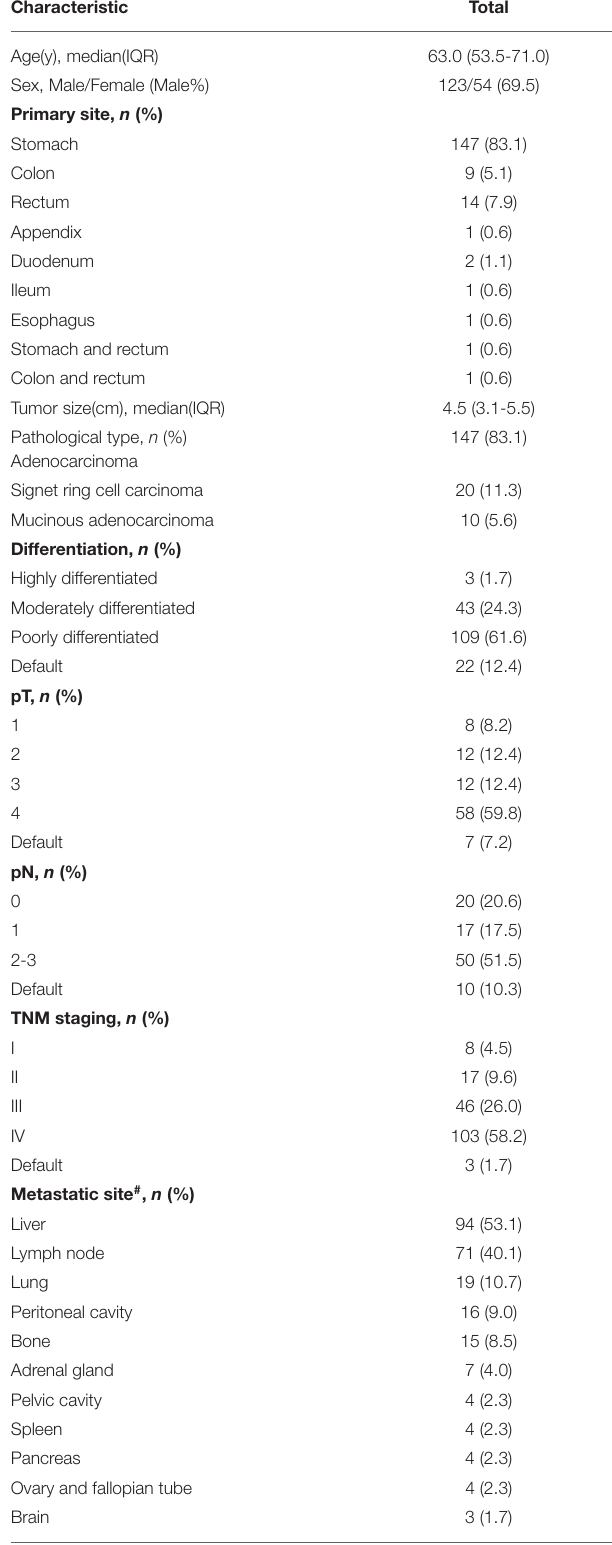
TABLE 1 | Baseline Characteristics of